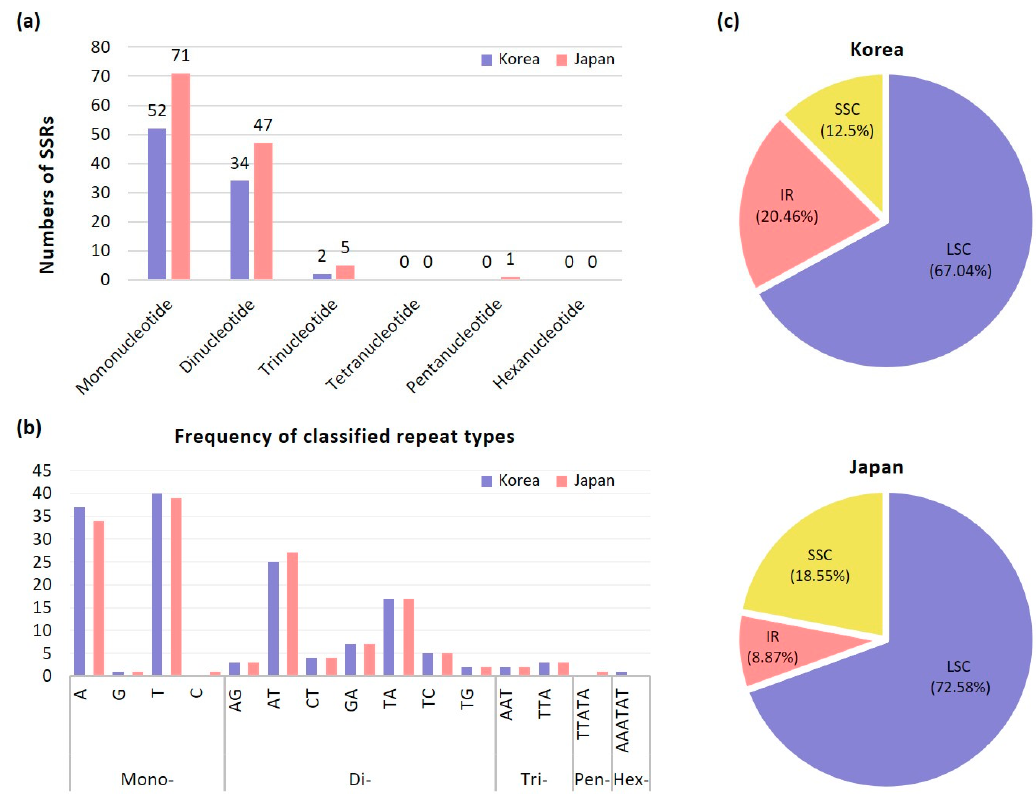
Figure 3. Analyses of repeated sequences in two accessions of Symplocarpus nipponicus plastome. ( A ) Numbers of different repeat types; ( B ) Numbers of identified SSRs motifs in different repeat class types; ( C ) Frequency of repeat types in LSC, SSC, and IR regions.